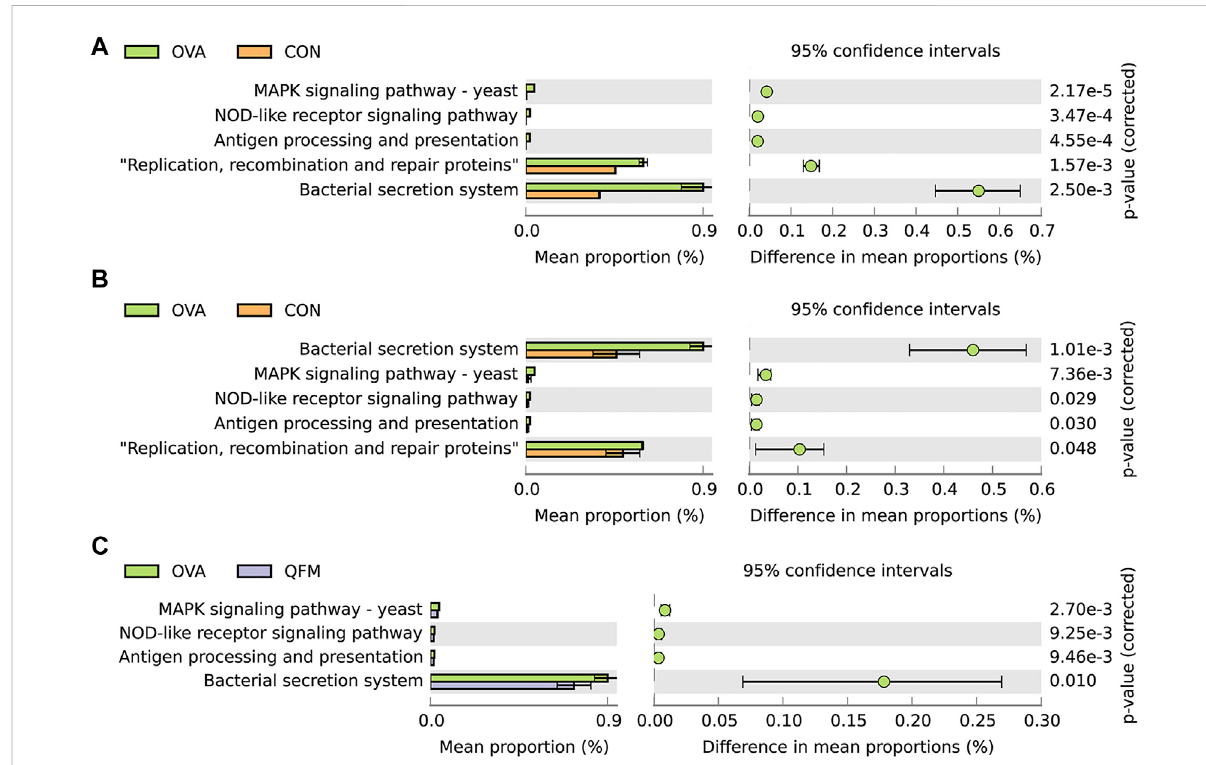
FIGURE 7 Effects of Qingfei oral liquid (QF) on metagenomic functional prediction of the respiratory microbiota in ovalbumin (OVA)-induced asthmatic mice. Bacterial metagenomic functional categories were derived from Level 3 KEGG pathways. (A) Control group vs. the OVA group for the nasal lavage fl uid(NLF)microbiota. (B) Controlgroupvs.theOVAgroupinbronchoalveolarlavage fl uid(BALF)microbiota. (C) BALFmicrobiotaoftheOVA group vs. the QF medium (QFM) concentration group. Gene functions with signi fi cant differences (corrected p -value ≤ 0.05, White ’ s non- parametric t test in STAMP) and parts of the pathways associated with asthma are